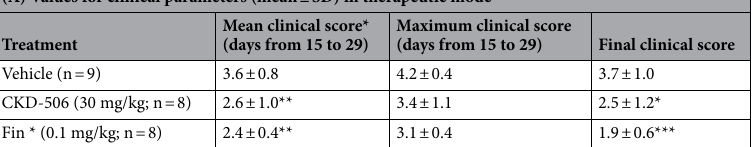
Table 2. Values of the mean clinical score, maximum clinical score, and final clinical score in the CKD- 506- and fingolimod-treated experimental autoimmune encephalitis (EAE) groups under the therapeutic regimen. Data are presented as mean ± SD (* p < 0.05, ** p < 0.01 and *** p < 0.001, drug-treated group vs. vehicle group). Results were analyzed using Kruskal–Wallis test, followed by multiple comparisons post-hoc test with Dunnett’s test for maximum clinical score and using one-way ANOVA followed by Dunnett’s post-hoc test for mean clinical score and final clinical score. *The mean clinical score was calculated as follows: The mean clinical score = the accumulated score / evaluated days. *Fin, Fingolimod-treated